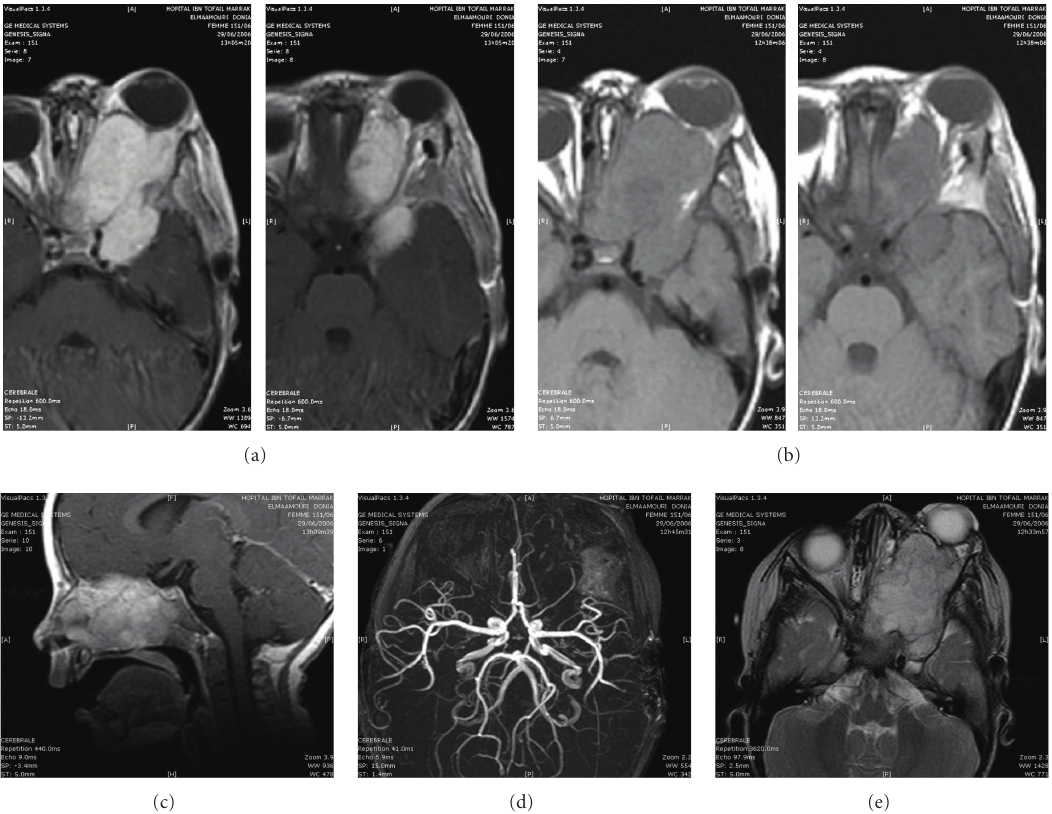
Figure 3: Magnetic resonance imaging in the axial (a, b, and e) and sagittal (c) planes showing the tumoral process in low signal in T1 (b) and high signal in T2 weighted images (e) as well as intense and homogeneous enhancement after contrast administration (a, c). The angio RMI sequence (d) shows the vascular character of the tumor (d).